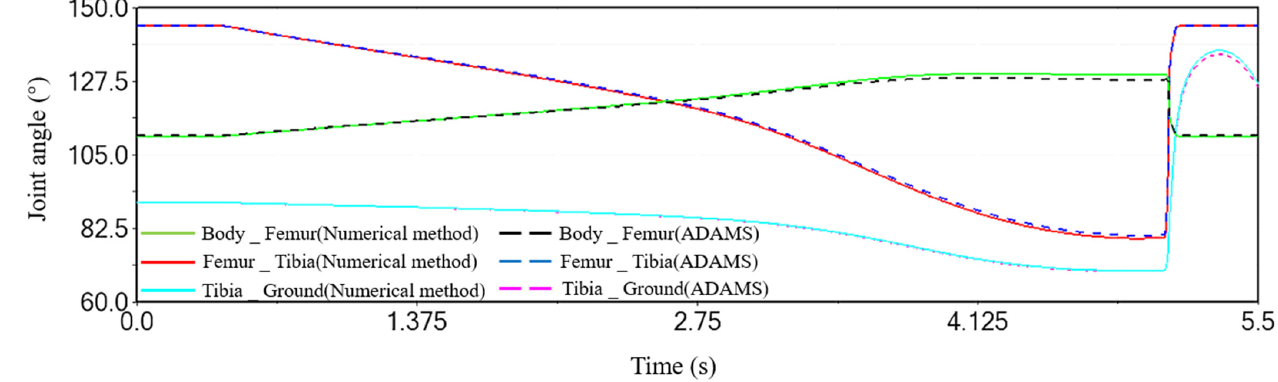
Figure 8. Joint angle during the take ‐ off phase of the robot.